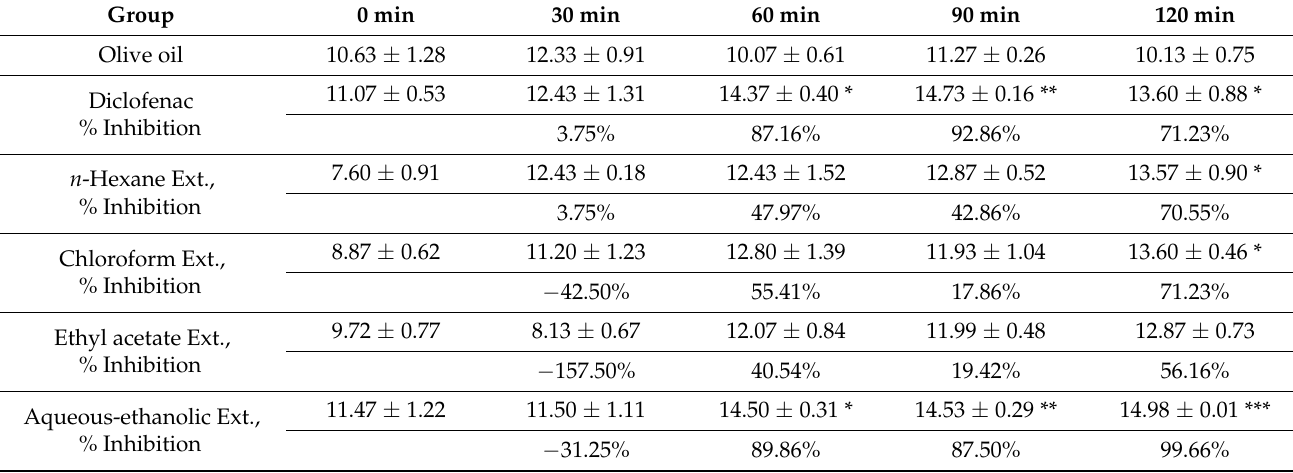
Table 4. Analgesic effects of the S. cyclophylla extracts, and% inhibition of pain in mice assessed by hot-plate method ‡ . Group 0 min